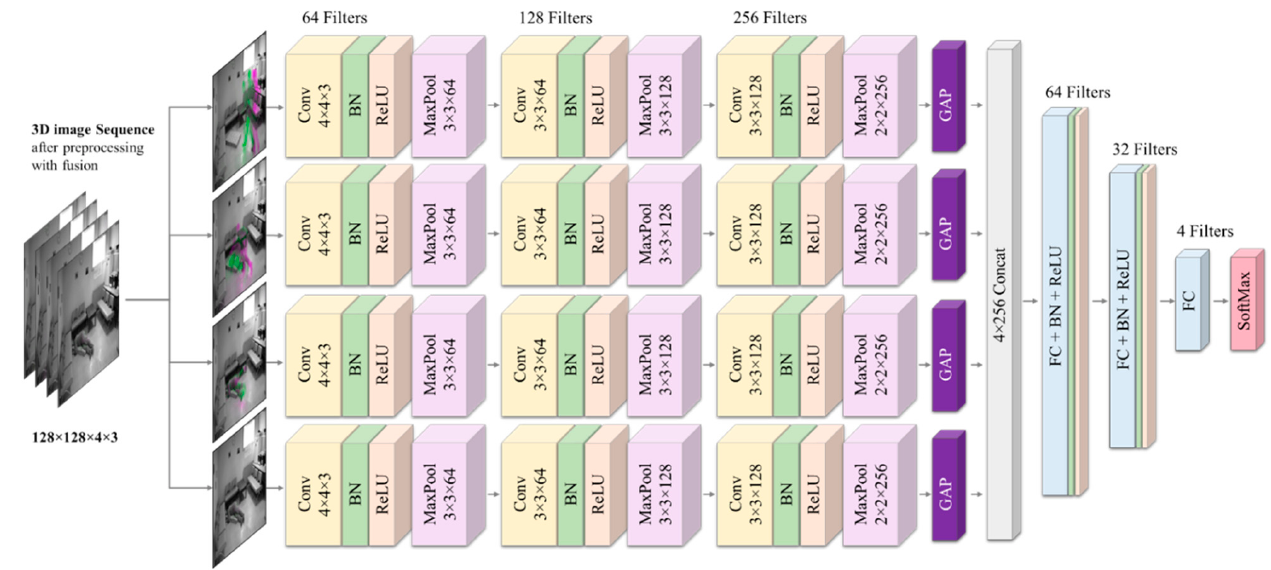
Figure 5. The proposed 4S-3DCNN model architecture for human fall detection .